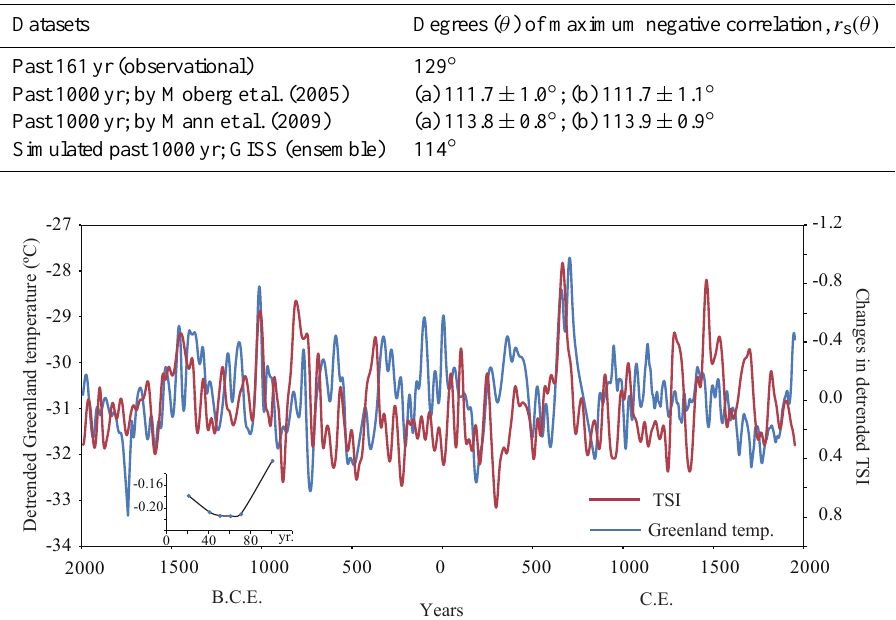
Fig. 5. Greenland temperature and solar activity over the past 4000yr. Both time series are linearly de-trended and smoothed with 21-yr RMs. Greenland temperature (Kobashi et al., 2011) and solar activity (Steinhilber et al., 2009) have weak but significant negative correlation ( r = − 0.18; p =0.09). 21-yr RMs were chosen as other smoothing with various periods showed lower confidence levels although they had in some cases higher correlation coefficients (see panel in left bottom). Note that the axis for the TSI is reversed.